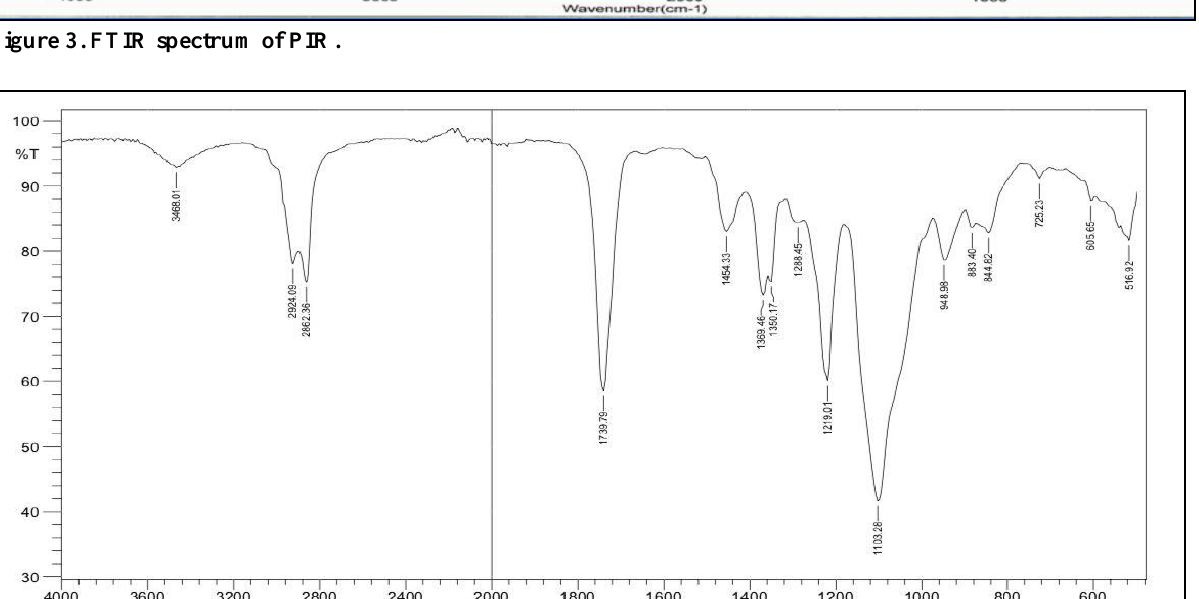
5 .The obtained result indicated approximately spherical shape of the